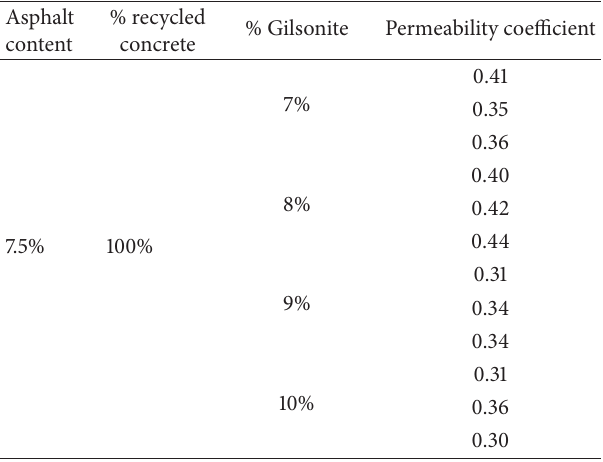
Table 11: Results of permeability test on specimens with Gilsonite additive.